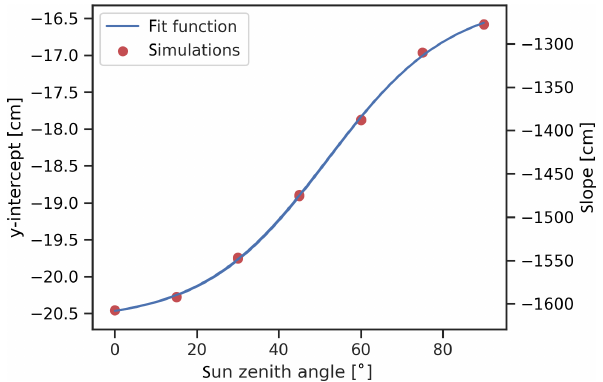
Figure 10. Change in model’s y intercept and slope with solar zenith angle. Generalized logistic function fit into the simulated